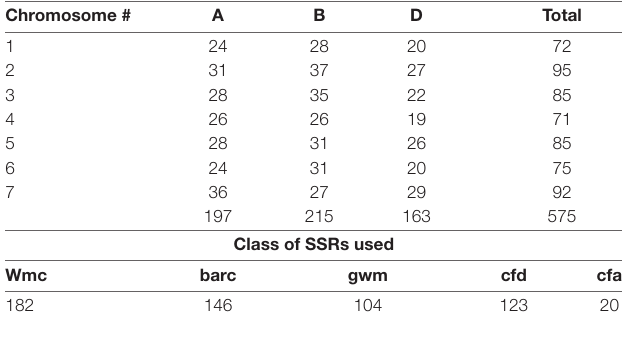
TABLE 9 | Brief summary of molecular markers used for background recovery in PBW723. Chromosome